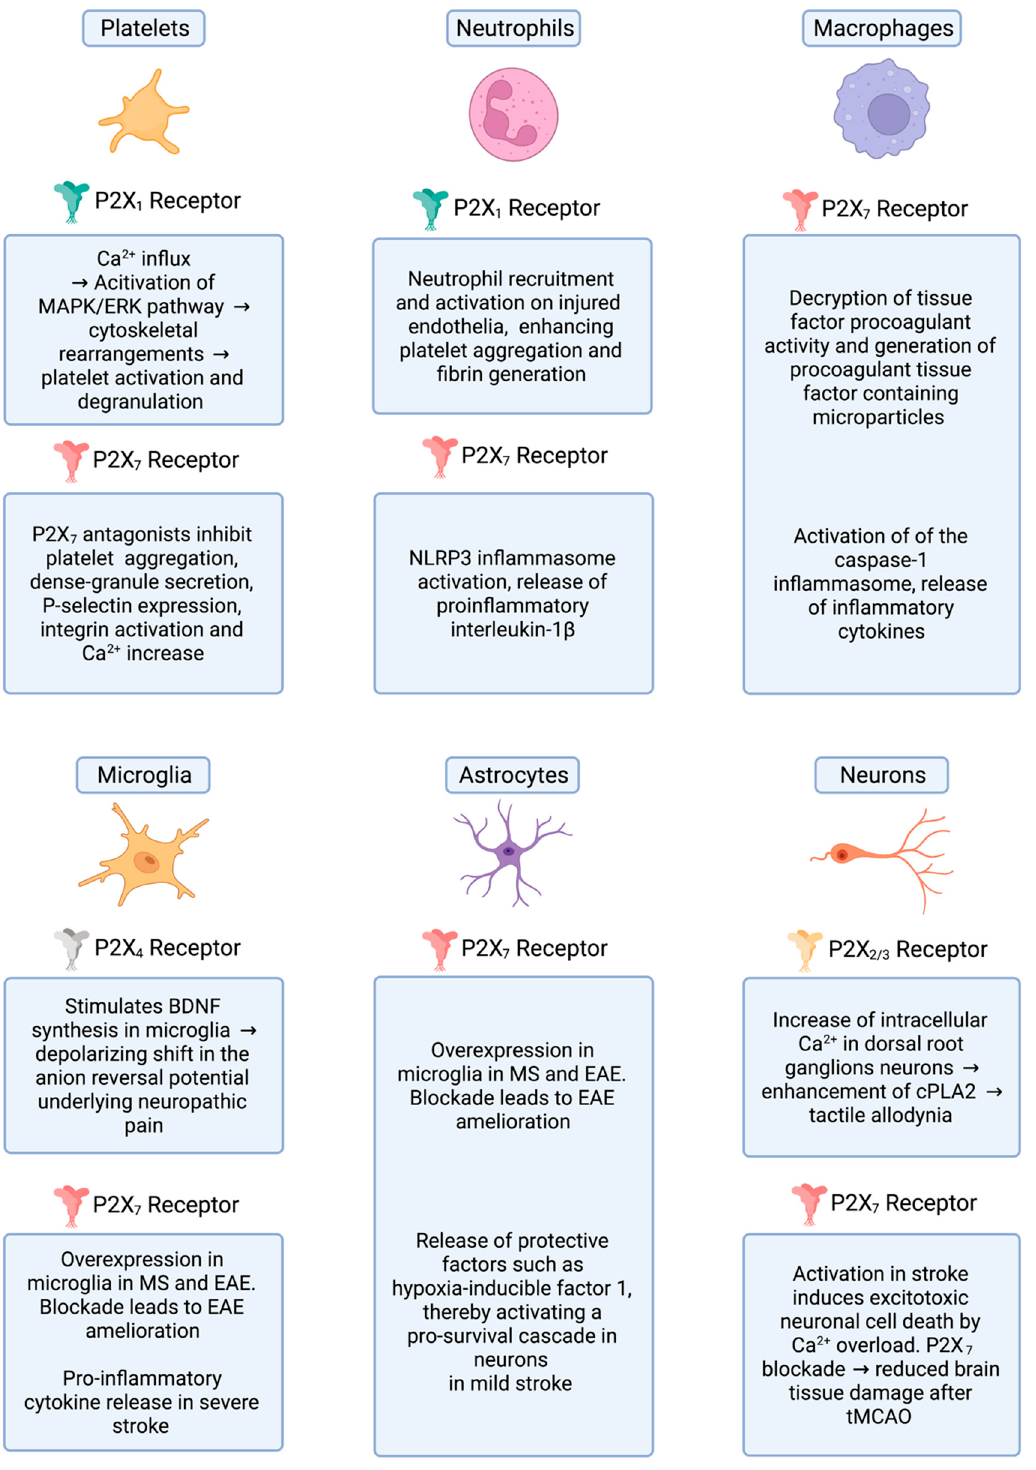
Figure 1. The role of P2X receptors in different cell types.